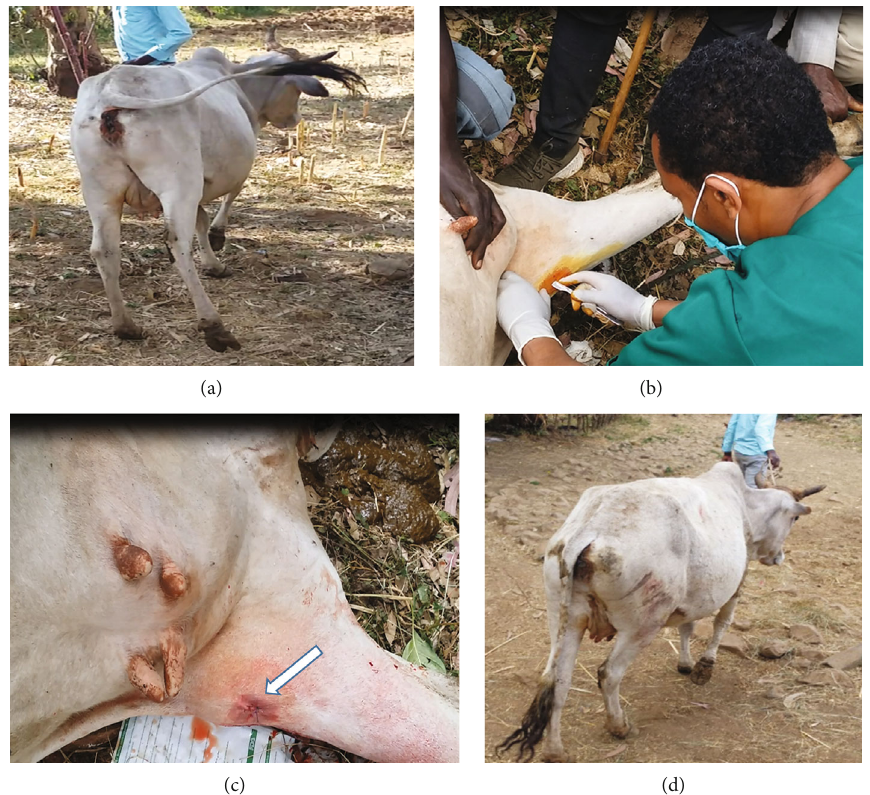
Figure 1: Clinical presentation, management of upper fi xation of the patella, and its outcome. (a) Locked sti fl e joint and dragging right hoof. (b) Stab skin incision for medial patellar desmotomy. (c) After the closure of the skin incision. (d) Cow walking normally just after the